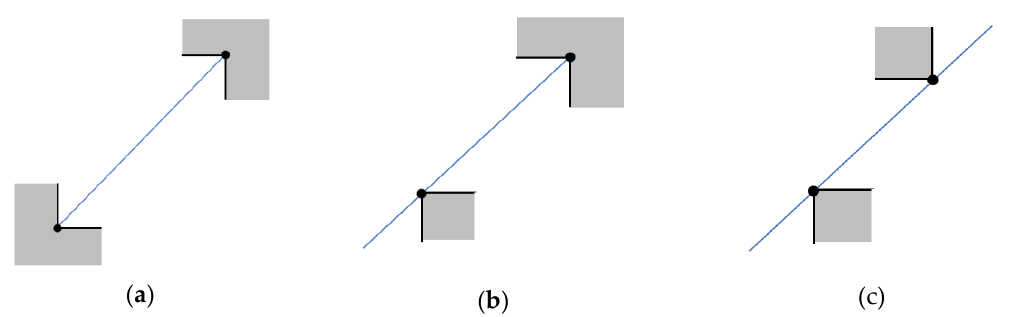
Figure 6. Three cases of axial lines generation, ( a ) convex–convex, ( b ) convex–reflex, ( c ) reflex–reflex.